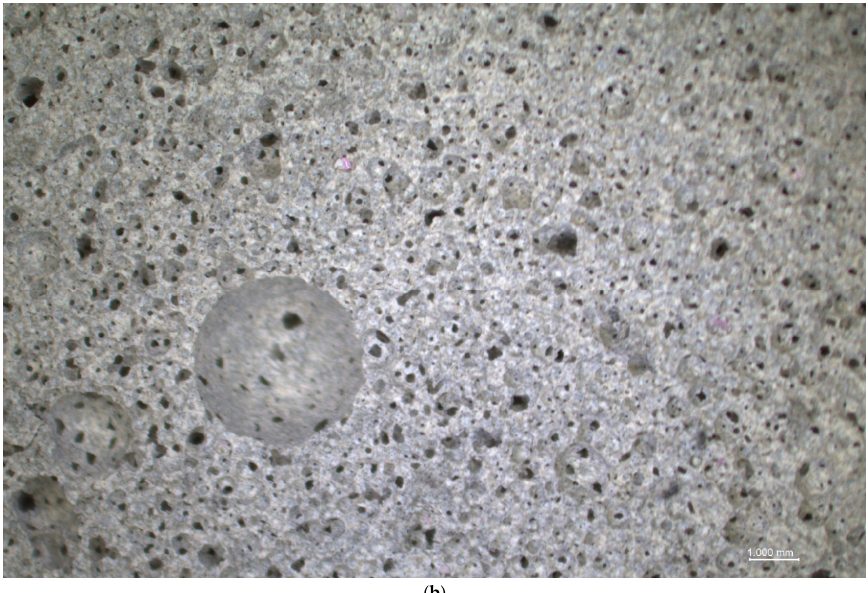
Figure 6. Light microscopy image of hardened foamed concrete samples with density of around ( a ) 800 kg/m 3 , ( b ) 700 kg/m 3 .